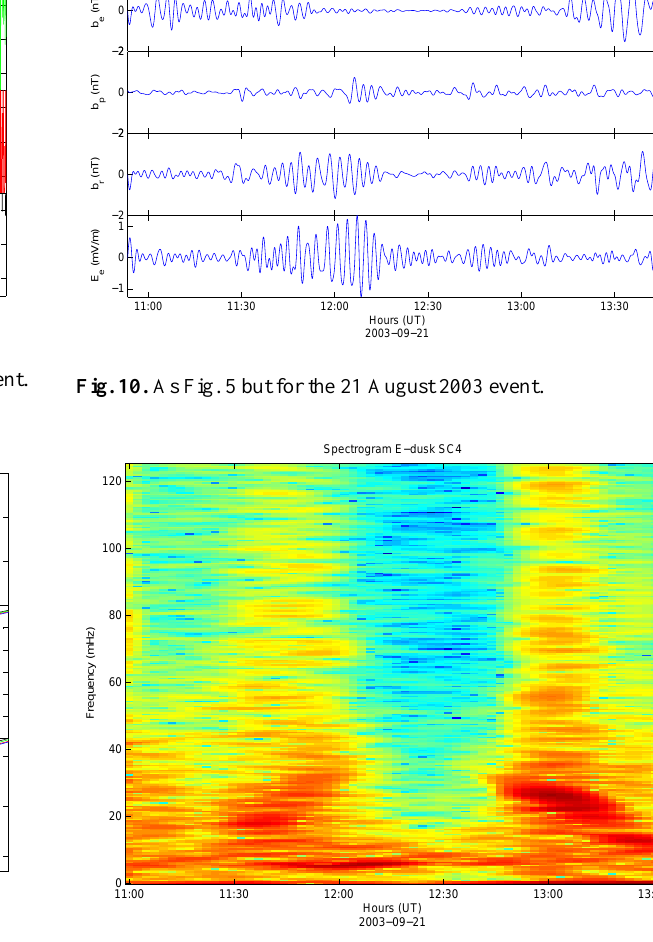
Fig. 11. Spectrogram for the duskward electric field measured by s/c 4 on the 21 September 2003 event.